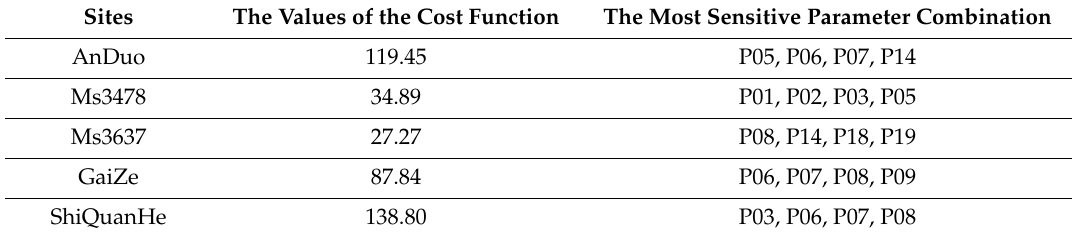
Table 3. The most sensitive parameter combinations for SH at di ff erent sites and their corresponding values of the cost function.